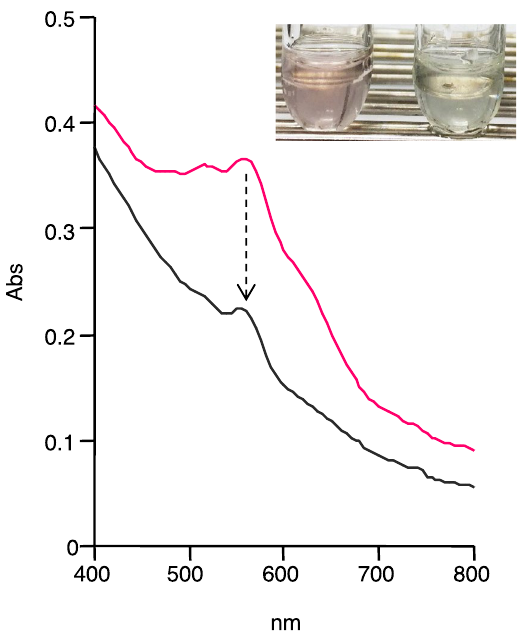
Figure 6. Decolorization of wastewater collected from a dyeing factory by IOX. The reaction mixture (1.5 mL) contained the wastewater (1.3 mL), 100 mU mL − 1 of IOX, and 1 mM iodide. The reaction time was 2 h. UV- visible absorbance spectra before (pink line) and after (black line) the decolorization are shown. Inlet shows a photograph taken before (left) and after (right) the